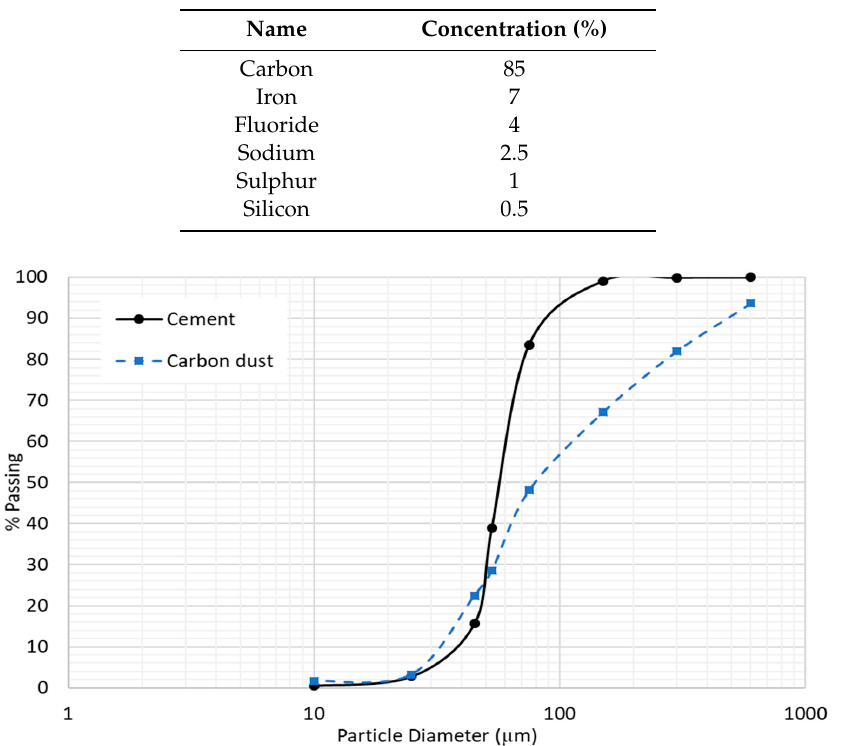
Table 4. XRF analysis of carbon dust.